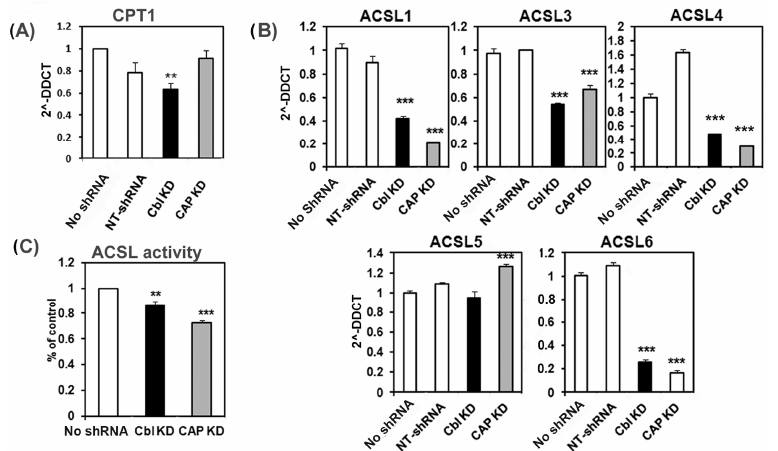
Figure 7. CBL- and CAP-depleted cells have reduced expression of genes involved in fatty acyl-CoA import into mitochondria. mRNA levels of Cpt1 ( A ) or long chain Acyl CoA synthases ( Acsl1-6 ) ( B ) were determined by qPCR. ( C ) Acetyl CoA liase activity was measured on 14 C-palmitate in cellular lysates from untransfected (no shRNA), CBL shRNA (CBL KD), CAP shRNA (CAP KD), or NTshRNA-expressing cells. Graphs show mean ± SEM. Statistical analysis: one-way ANOVA to control untransfected with Bonferroni post hoc test. ** indicates p < 0.01 *** p < 0.001.